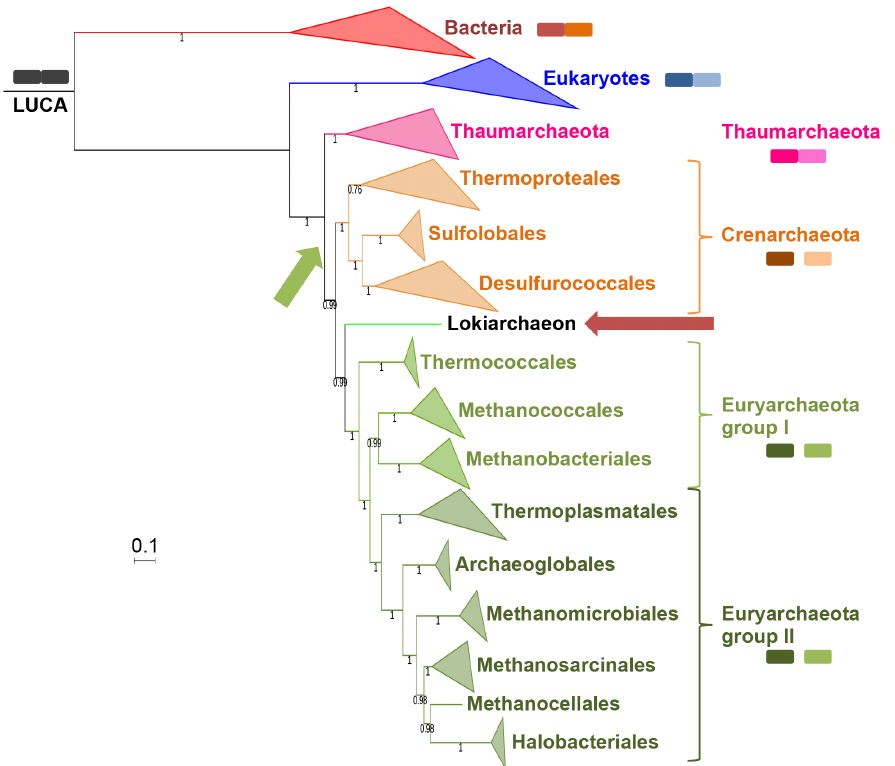
Fig 7. RNA polymerasephylogeny. Bayesianphylogeny(LG model + Γ 4) of the concatenated alignments of the two largest RNA polymerase subunits(1,463 positions)from an equal number(39) of Archaea, Eukaryotes (blue) and Bacteria (red). Among the Archaea, Thaumarchaeota, Crenarchaeota, group I Euryarchaeota and group II Euryarchaeota are indicatedin pink, orange, light-greenand dark-green, respectively. Values at nodesrepresent the Bayesianposterior probabilities. Detailedtree in S30 Fig. See S31 Fig for CAT-GTR model tree, and S32 Fig for ML tree. The scale-barrepresentsthe averagenumberof substitutionsper site. A red arrow indicatesthe Lokiarchaea positionin the tree. The A subunitstatus (split or fused) is indicatedby adjacencyof colored squares. The green arrow indicatesthe position of the split event amongthe